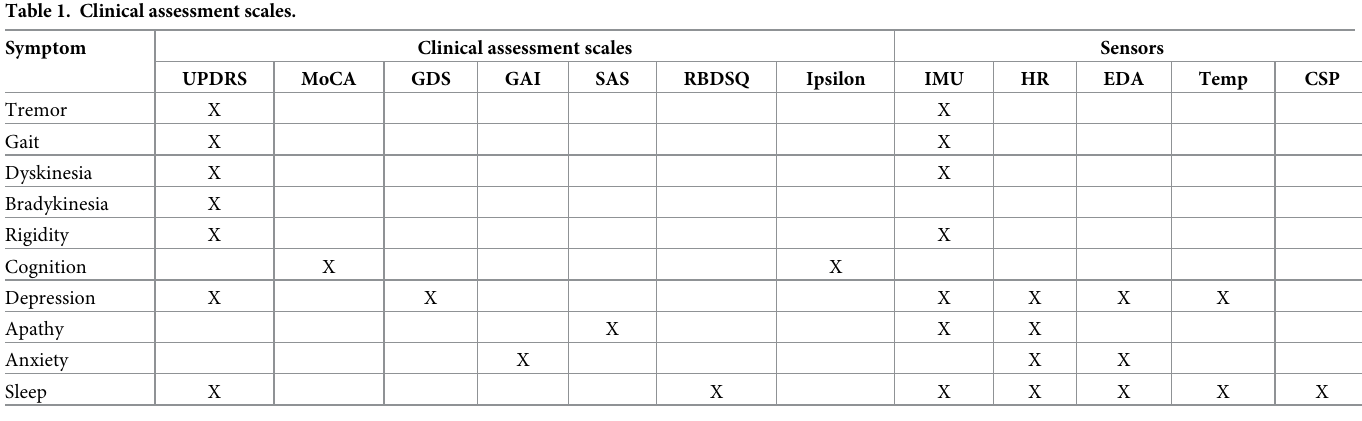
and user-centred interventions. In a cyclic manner, we tune and adjust the algorithms and models that analyse the data collected from the participants, based on the performance indica- tors of each cycle. After the tuning process is completed, these indicators become the outcome measures of ActiveAgeing: